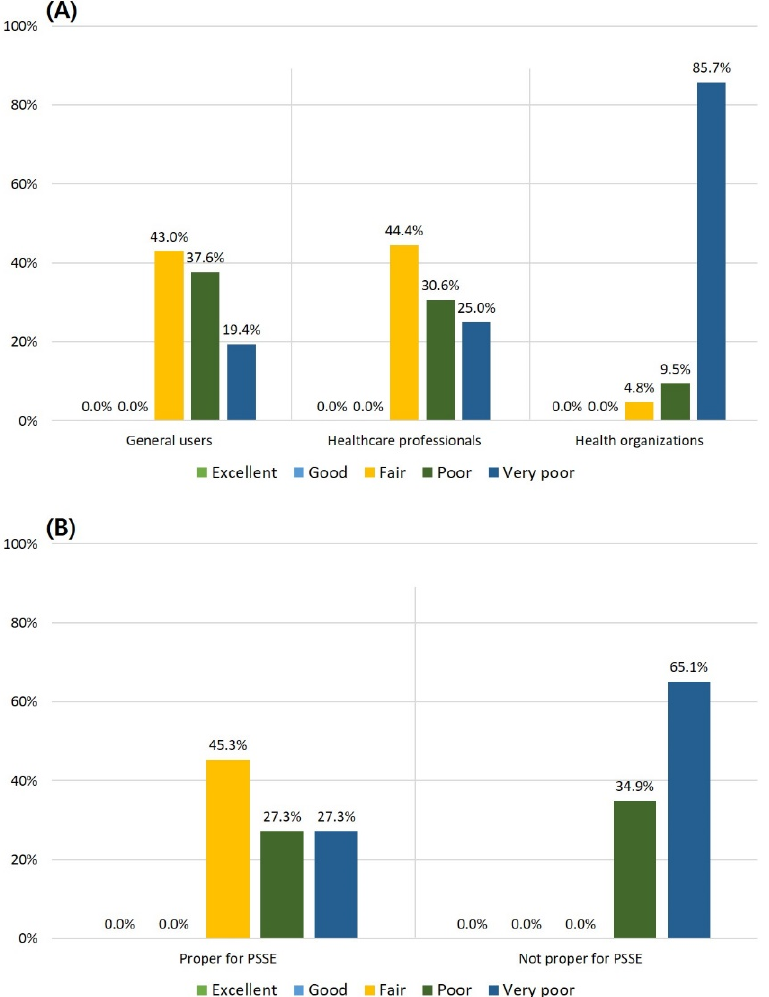
Figure 2. ( A ) Distribution of DISCERN grades across the type of uploader of included videos and ( B ) distribution of DISCERN grades across the propriety for PSSE.